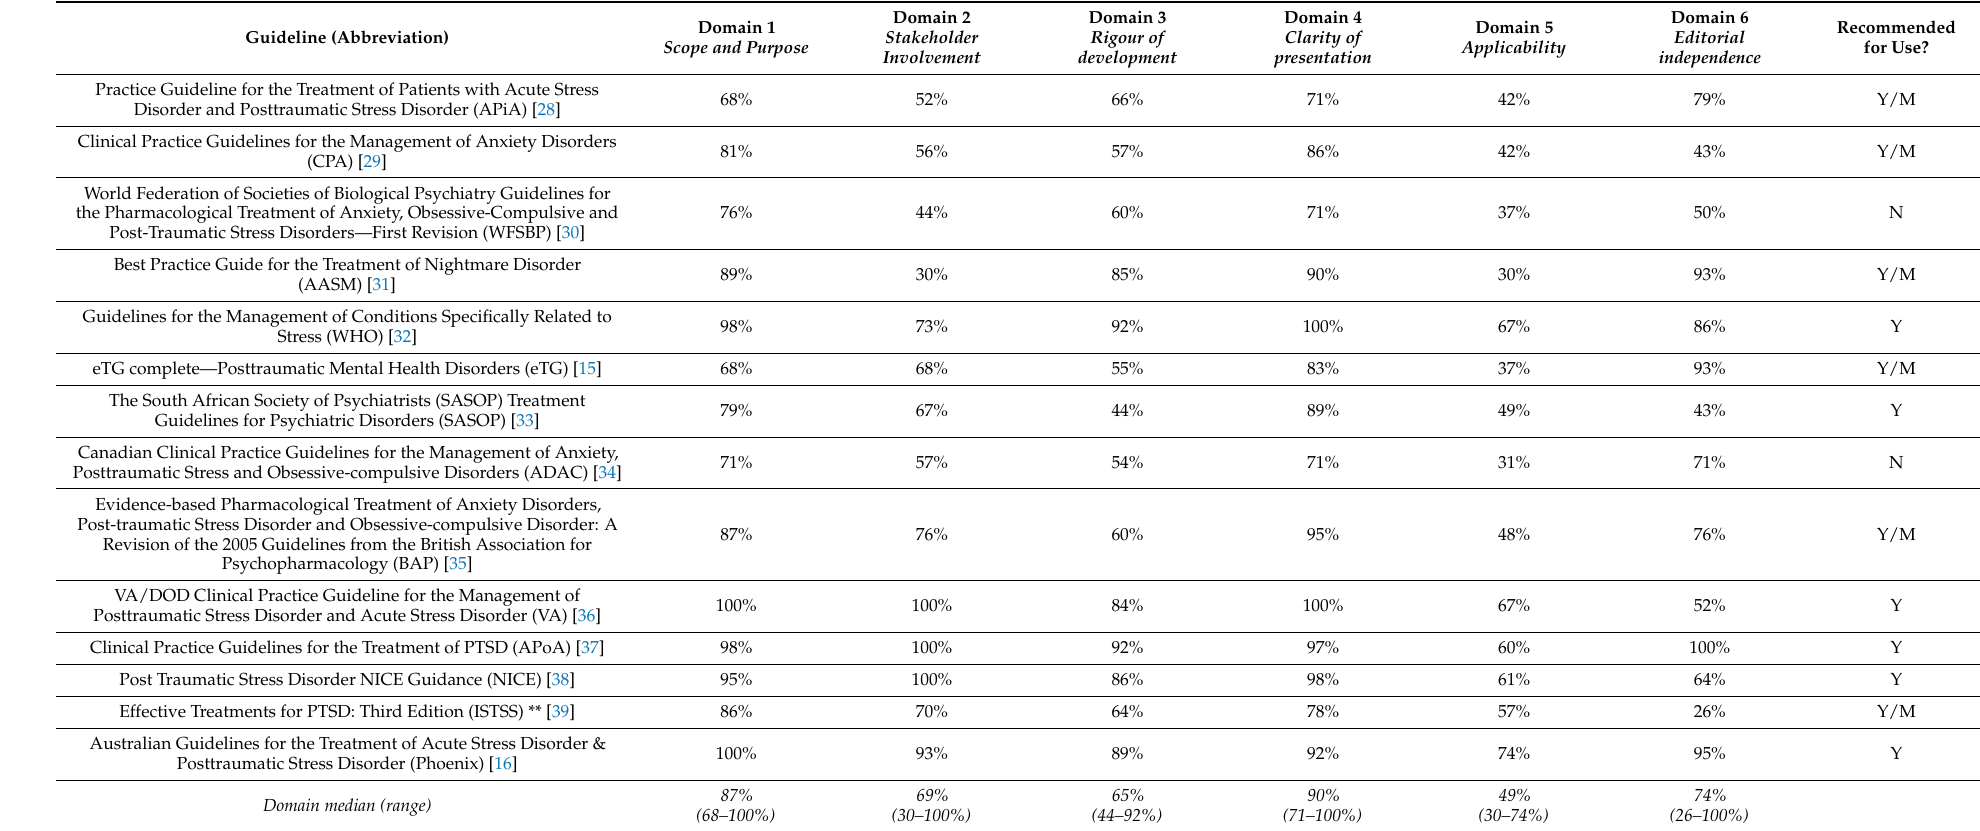
Table 3. AGREE II assessment scores * for each